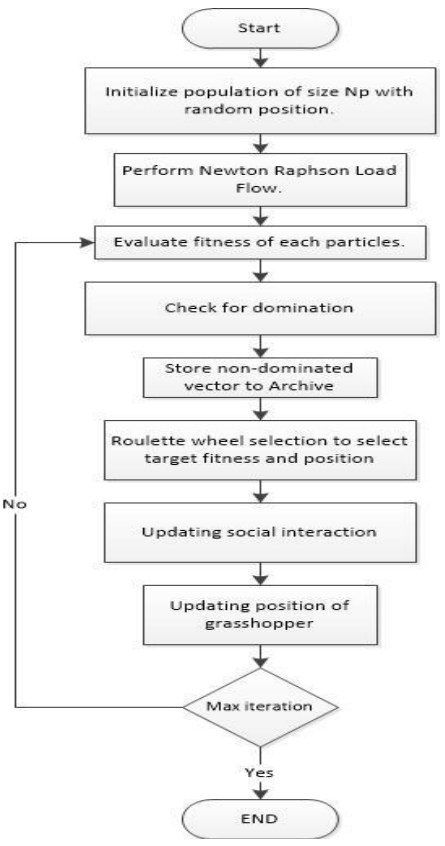
Figure 1. Flow chart of MOGOA The Multi-objective Grasshopper Optimization algorithm is as follows [24]: 1. Initialize the input parameters for the optimization algorithm and the control variables for the objective function. 2. Create a population of size Np based on the input